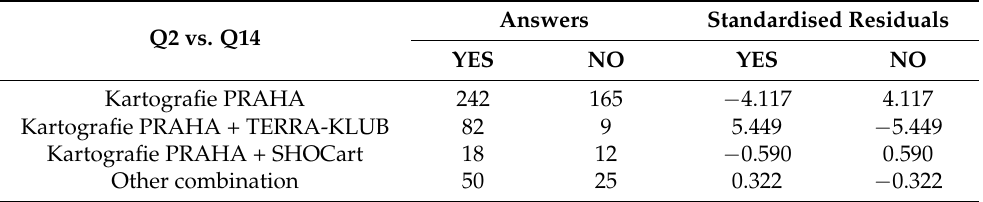
Table 3. The distribution of answers to Q2 and Q14, including the values of standardised residuals.